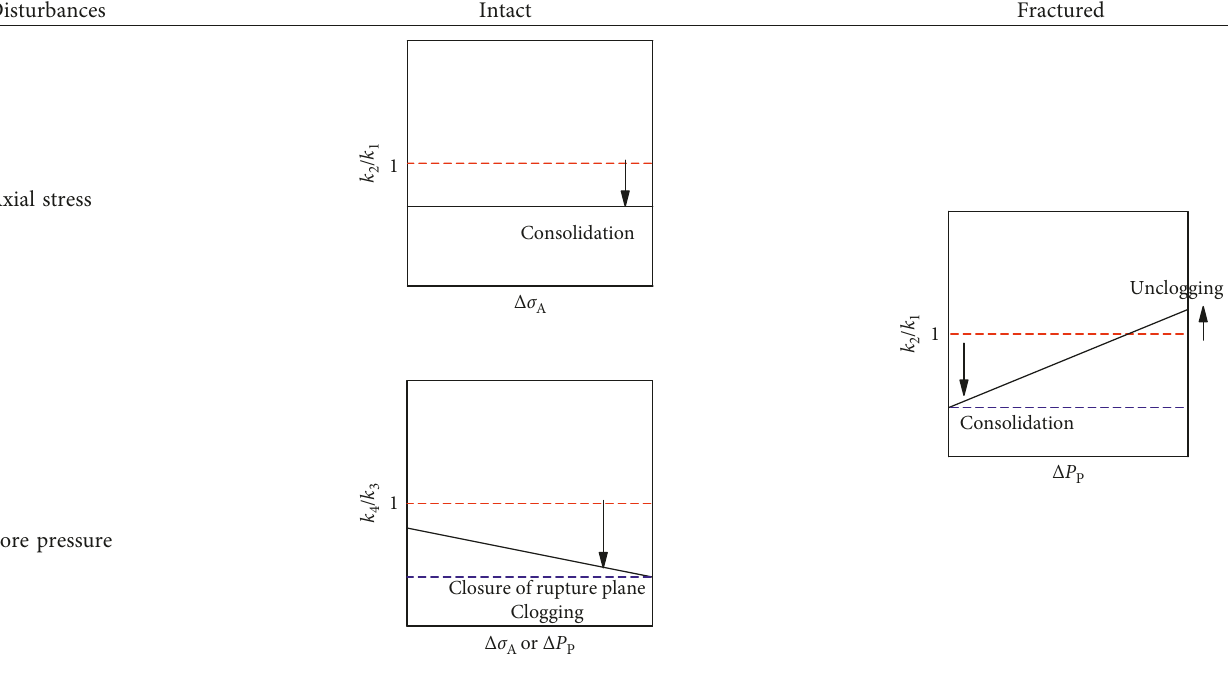
Table 6: Summary of the variations in permeability of the Kushiro Cretaceous sandstone.